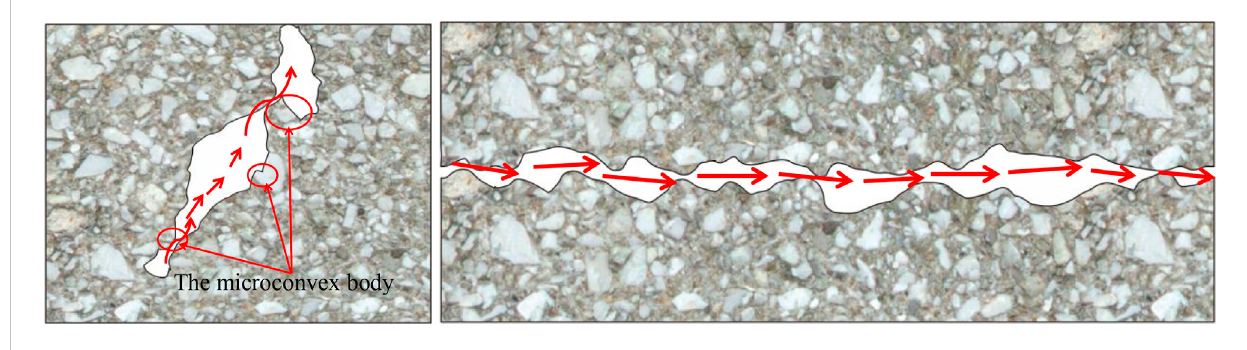
FIGURE 11 Fractures surface microconvex body support.